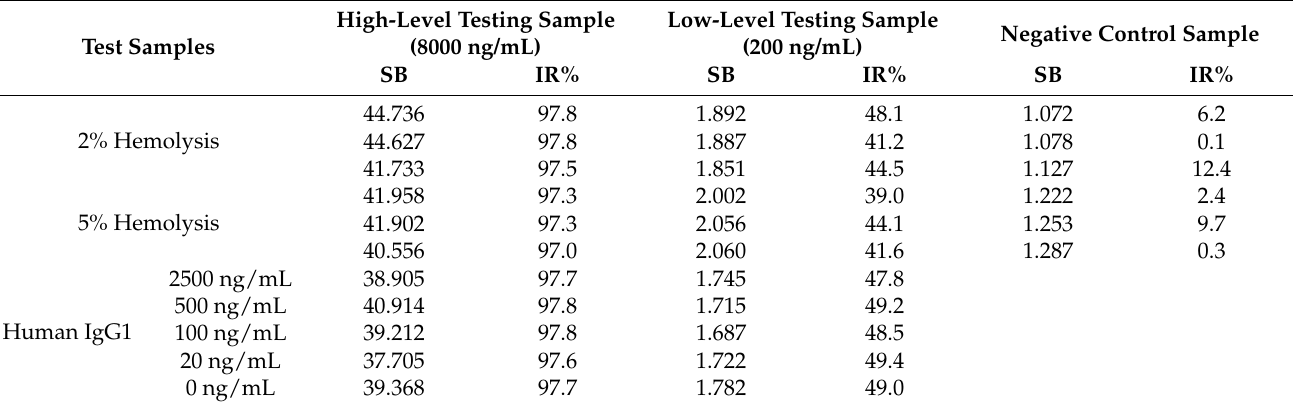
Table 2. Effect of hemolysis and specificity results.